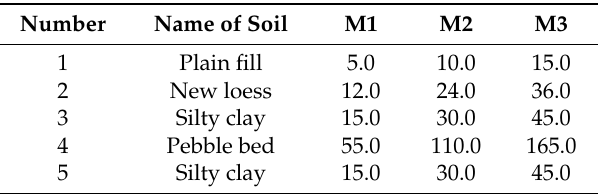
Table 6. Soil elasticity modulus